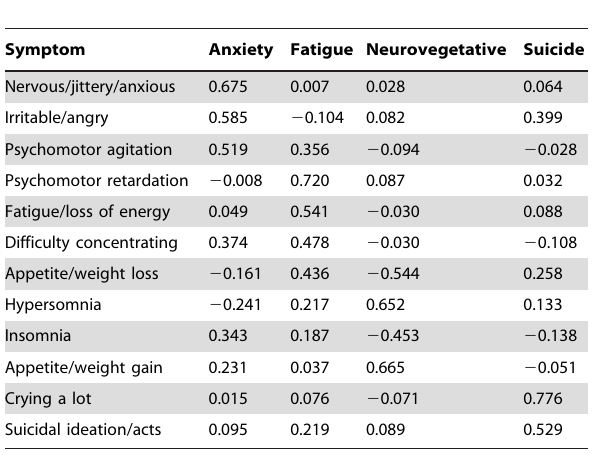
Table 3. Factor Loadings obtained from analysis of 12 major depression symptoms from medical records.